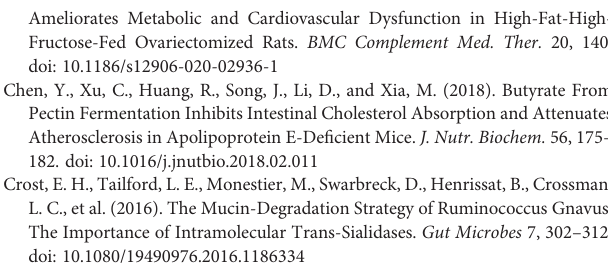
Supplementary Figure 1 | Correlation between Shannon diversity (A) or gene counts (B) with clinical variables. Supplementary Figure 2 | Prediction of clinical variables by MGS relative abundances with random forest models. Prediction accuracy was evaluated by the correlation between predicted value and the measured value. Supplementary Figure3 | Correlation between microbial functional modules and clinical variables. Heatmap showing correlations between functional modules and clinical variables (spearman correlation, p < 0.05). + q < 0.1; *q < 0.01. Color scale indicates the value of correlation coef fi cient. Supplementary Figure 4 | Correlation between urine metabolome and clinical variables. Heatmap showing correlations between functional modules and clinical variables (spearman correlation). Color scale indicates the value of correlation coef fi cient. Supplementary Figure 5 | Trans-omic correlation between microbial functional modules, the urine metabolome and clinical variables. Correlations between microbial functions and clinical variables, between urine metabolites and clinical variables, and between microbial functions and urine metabolites (spearman correlation, p < 0.05) are shown in the heatmap. + q < 0.1; *q < 0.01. Color scale indicates the value of correlation coef fi cient. Supplementary Figure 6 | Clinical phenotypes were different between non-CAS and CAS groups. Wilcoxon rank-sum test was performed between non-CAS and CAS groups. Supplementary Figure 7 | PCoA of the genus composition in the gut microbiota. non-CAS, blue circles; CAS, red triangles. Supplementary Figure 8 | Mild alterations of the gut microbiota composition in CAS. (A) Comparison of gene counts (the left panel) and a-diversity (the right panel) of the gut microbiota in non-CAS and CAS individuals by Wilcoxon rank-sum test. (B) MGS differing in abundance between non-CAS and CAS at p<0.05 but q>0.1. Supplementary Figure 9 | Functional alterations of the gut microbiota in CAS. Differentially enriched modules at Z-score>1.6 as analyzed by KEGG (A) and by GMM (B) are shown. Green, enriched in the non-CAS group; red, enriched in the CAS group. Bar length indicates the value of reporter